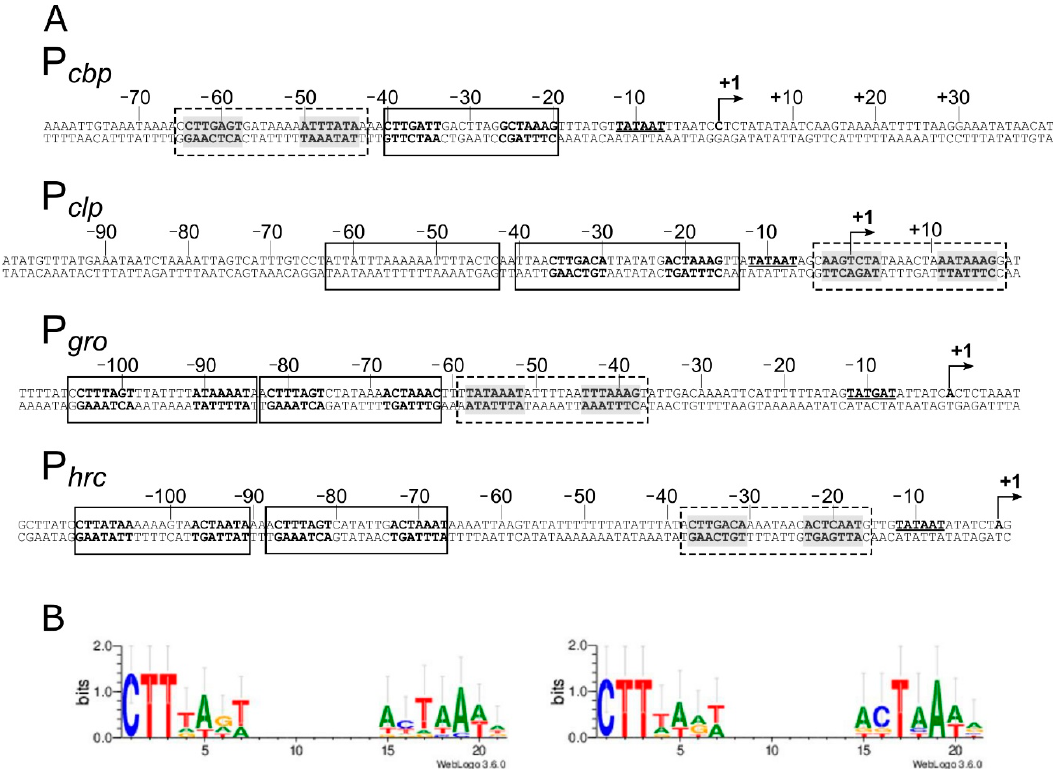
Figure 2. Features of the heat ‐ shock promoter sequences and definition of HspR consensus binding motif. Panel A : for each promoter sequence, the numbers refer to the positions with respect to the transcriptional start site (+1), and the − 10 promoter element is in boldface type underlined on the coding DNA strand. The HspR Associated Inverted Repeat (HAIR) ‐ like sequences are represented in boldface on both strands. The HAIR ‐ like sequences identified in this study are shaded in grey. The DNase I protected regions are enclosed in boxes: solid line boxes indicate high ‐ affinity binding sites, while dashed line boxes delimit low ‐ affinity binding regions. Panel B : HAIR consensus motifs derived in this study, visualized by inputting WebLogo with the alignment of all identified HAIR (left panel) or the alignment of the HAIR sequences bound with higher affinity by HspR (right panel). In both sequence logos, the height of each letter represents the relative conservation of each base.